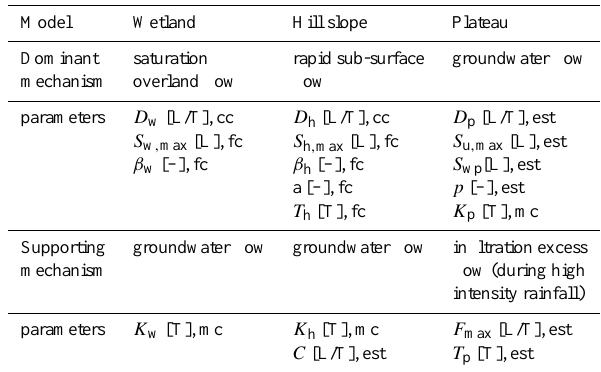
Table 2. Parameters involved in the three sub-systems: Wetland, Hill slope and Plateau. cc means constrained calibration, fc means free calibration, mc mean manual calibration and est means esti-